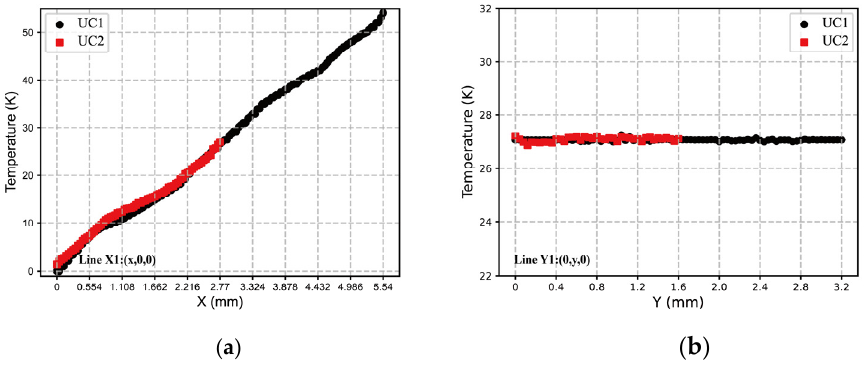
λ in UC1 and UC2.